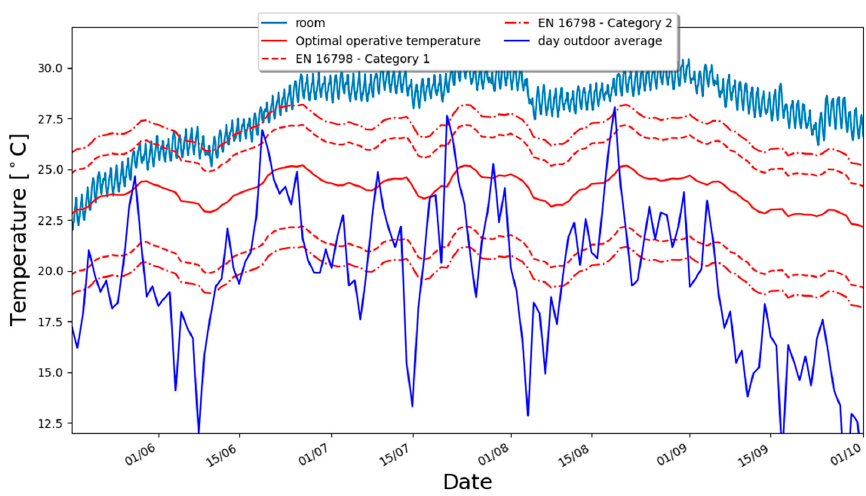
Figure 10. Temperature in the living room during the non-heating season; very low-emitting configuration.